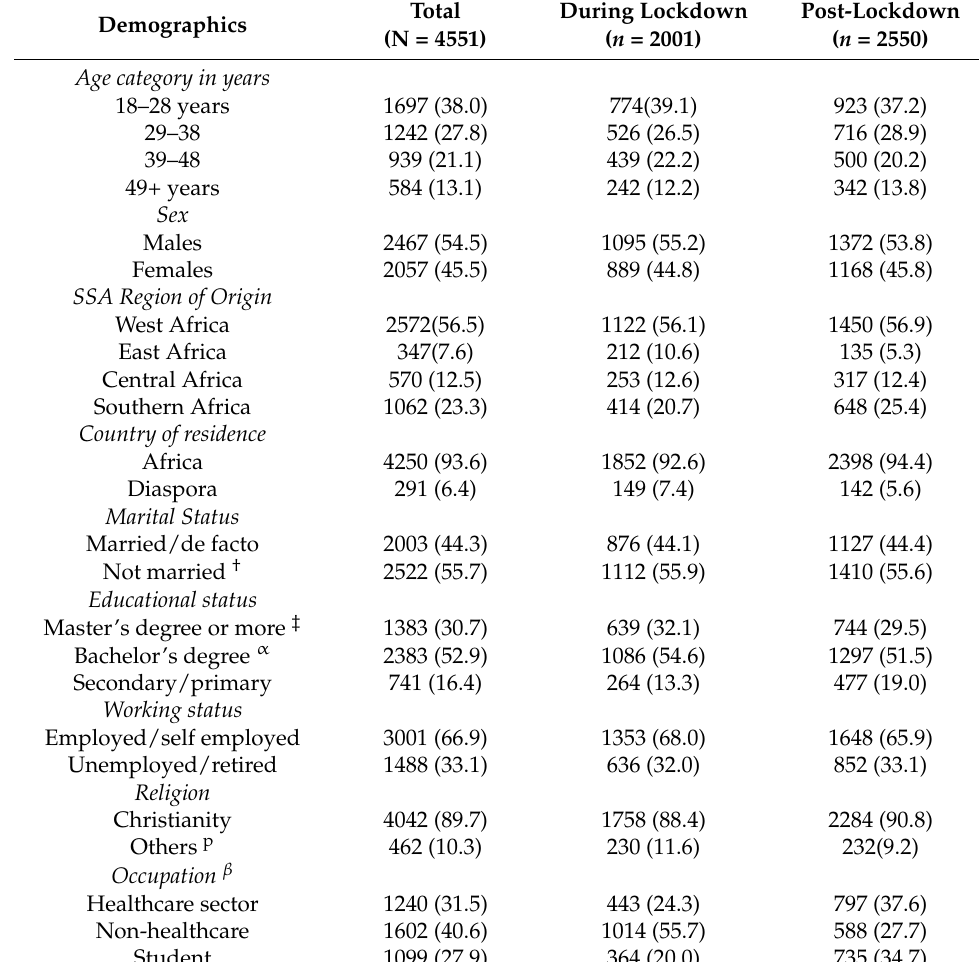
Table 1. Sociodemographic characteristics of respondents in both